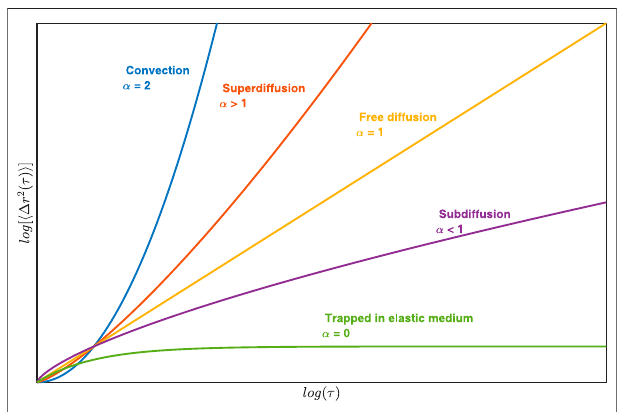
FIGURE1| PlotofMSD asafunctionoftime indicatingdifferenttypes of particle motion in the medium.